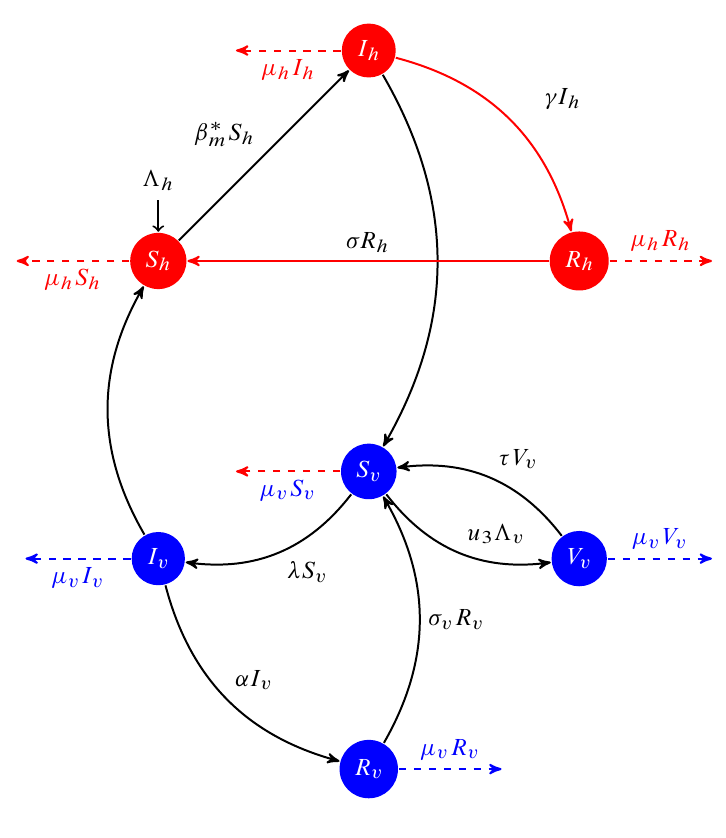
Fig. 1. Flow diagram for the disease transmission. The blue balls represent the vector population, while the red balls indicate the human